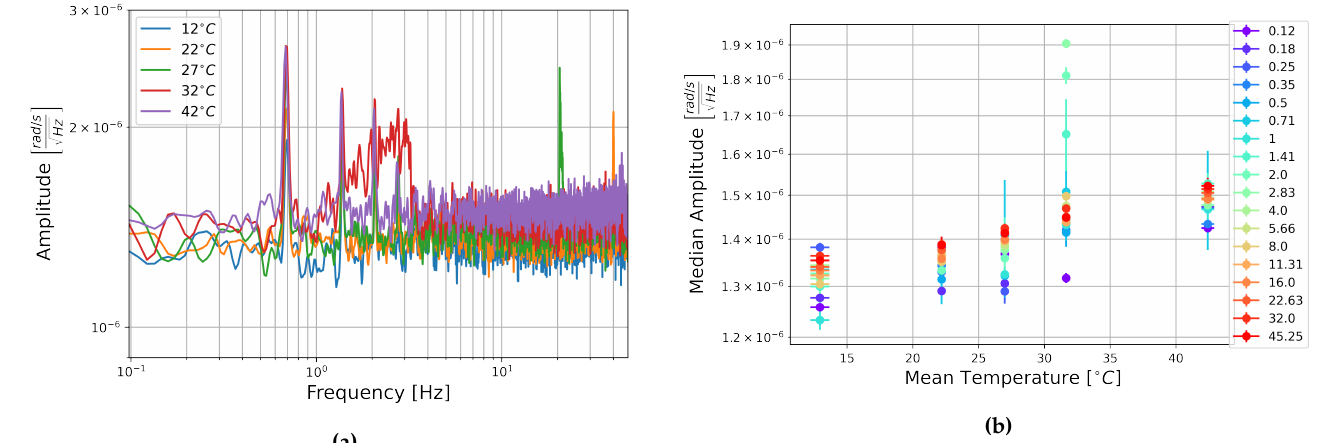
Figure 11. ( a ) Square root of the PSD of component HJY at each temperature step and ( b ) Median amplitude of the PSD per half-octave as a function of temperature. Vertical error bars show STD of amplitudes, and horizontal bars show STD of temperature measurements.